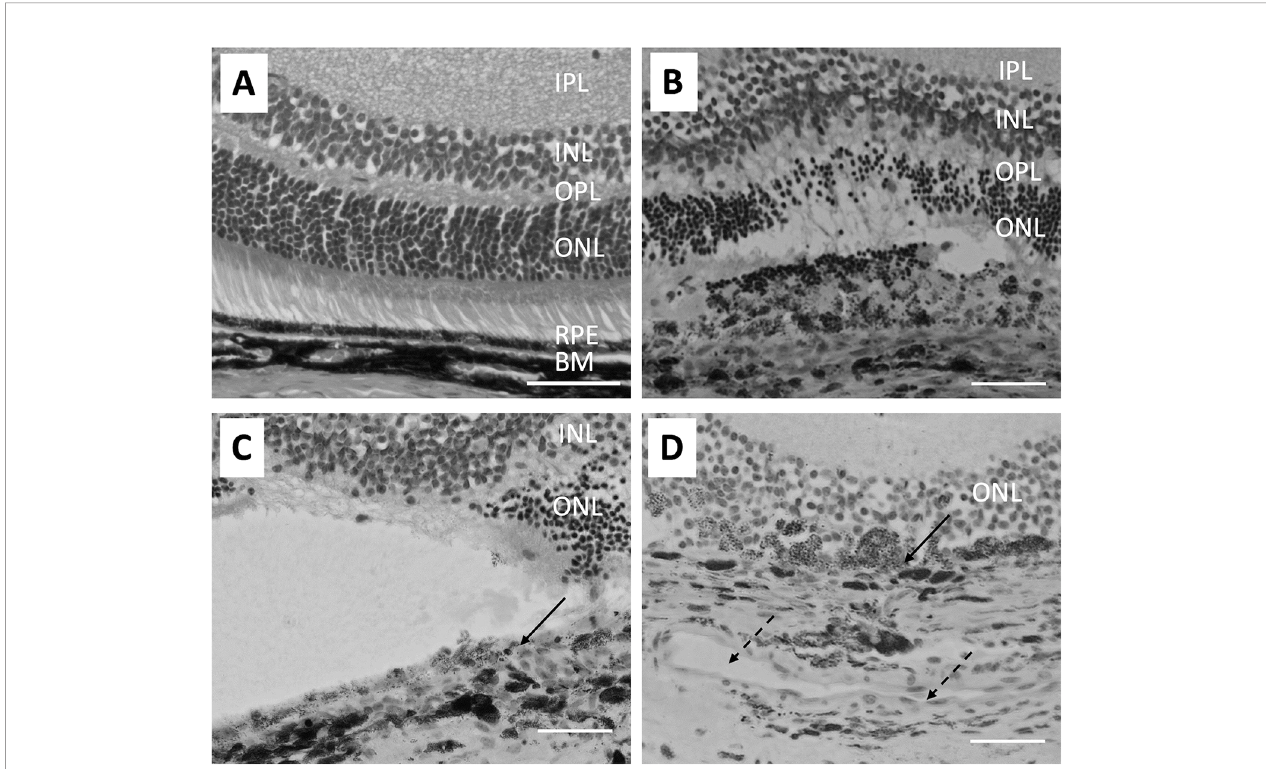
FIGURE 1 | Micrographs show the pathological changes of retina and choroid from day 0 to day 14 after laser injury. (A) shows a healthy naive retina. The RPE is a single cell layer. (B) shows the retina on day 3 after laser injury. Bruch ’ s membrane is disrupted and RPE cells and most ONL cells are lost at the laser injury site. Also, arrangement of pigmented cells in the choroid is disrupted. (C) Similar histological structures are seen on day 5 after retinal laser-injury. Solid arrow points to the discontinued RPE cells. (D) shows the retina 14 days after laser injury. A large capillary (broken arrows) forms in the choroid adjacent to the laser injury site. Macrophages fi lled with pigment are found in the ONL and some RPE (solid arrow) are found covering the injured site with a disrupted Bruch ’ s membrane. The size bar is 50 microns in